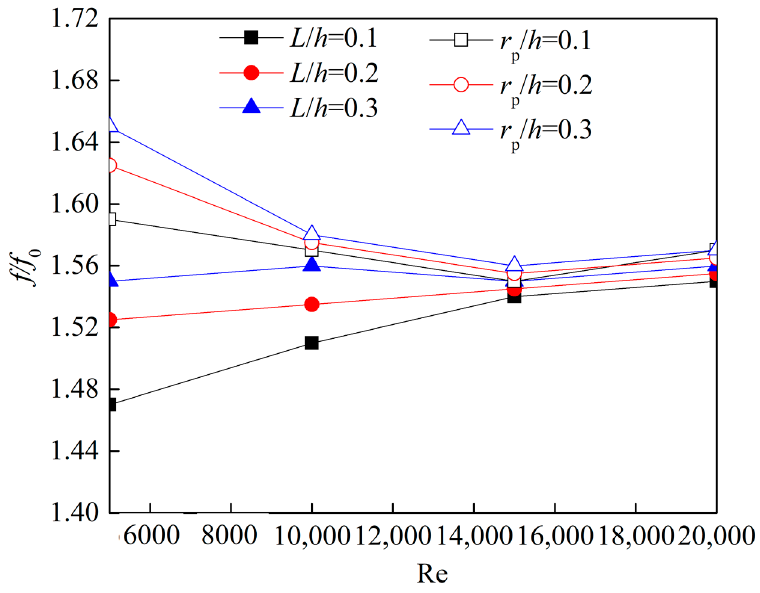
Figure 16. Effect of Reynolds number on friction factor increment for different dimpled channel.